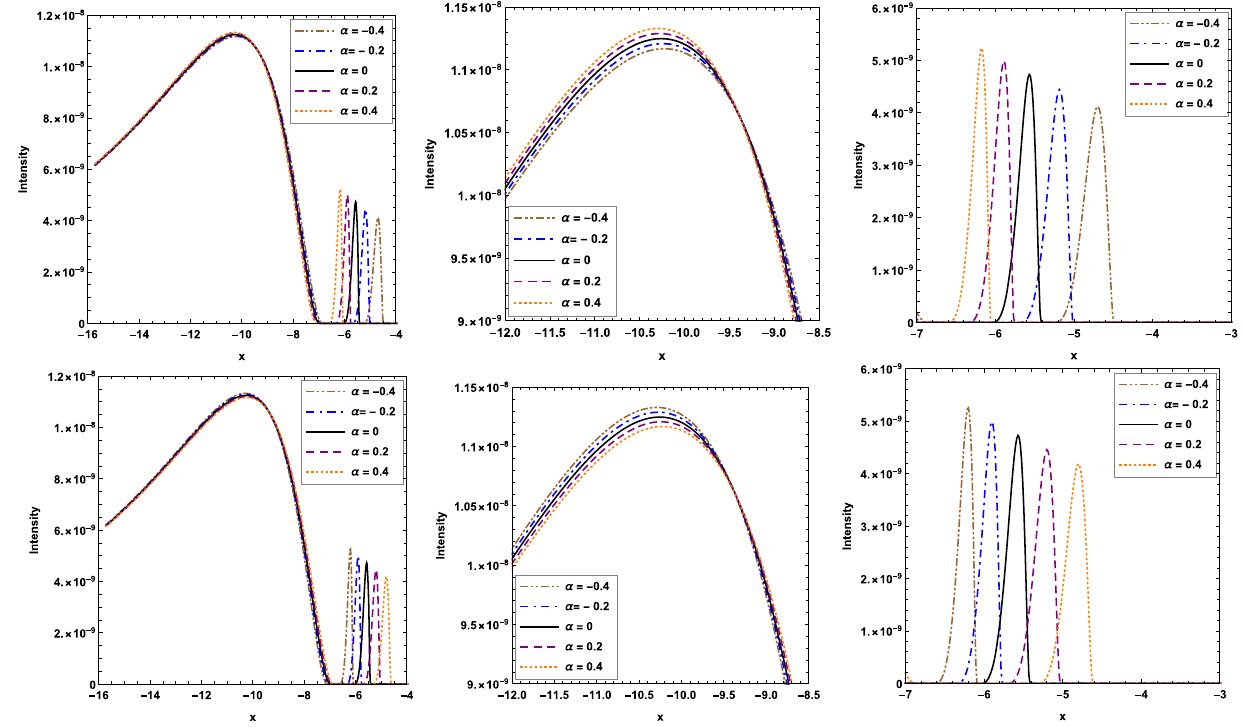
Fig. 5 The intensity distribution curve of images along the line y = 0 for the observer with inclination angle θ o = 70 ◦ . The upper row is for the PPL and the bottle row is for the PPM, respectively. Here, we set M =